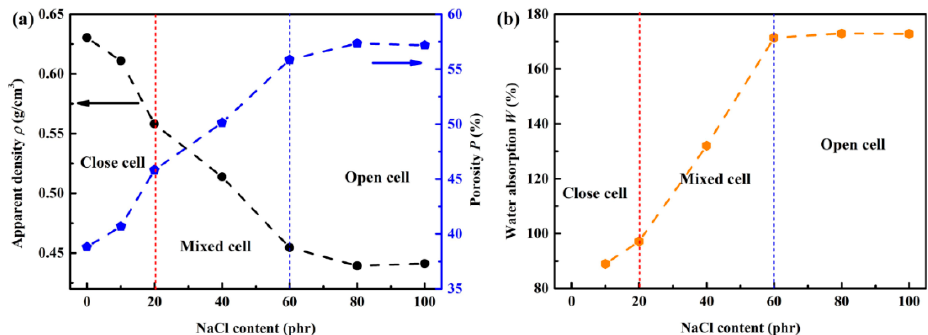
Figure 2. Cell structural properties of silicon rubber foams with different added amounts of NaCl. ( a ) Apparent density and porosity; ( b ) water absorption.